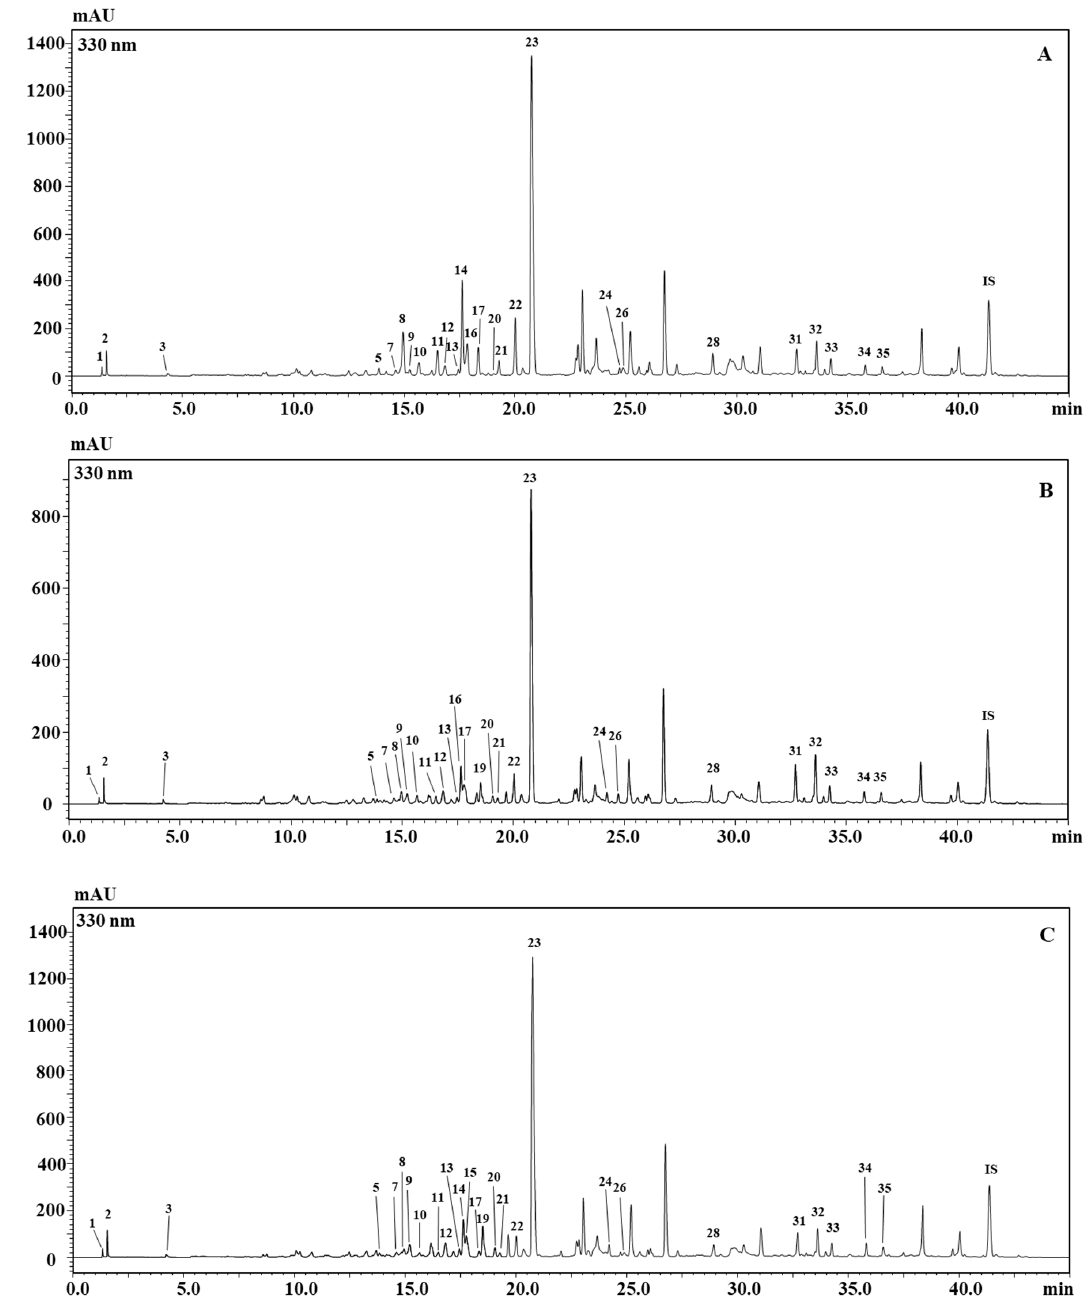
Figure 1. HPLC-PDA chromatograms of the metabolite content of flowers of the three Brassica accessions investigated. ( A ) B. juncea ISCI 99; ( B ) B. juncea ISCI Top; ( C ) B. juncea ISCI “ Broad- leaf”.